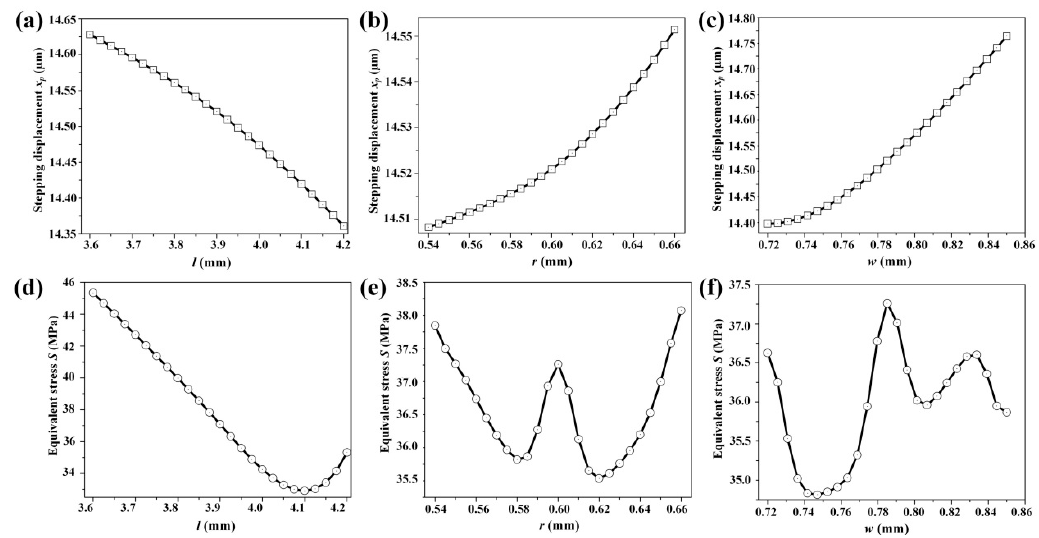
Figure 5. The dependence of the stepping displacement x p and maximum equivalent stress S on each of the design parameters: the change trend of stepping displacement with ( a ) l ; ( b ) r ; ( c ) w ; and the change trend of maximum stress S with ( d ) l ; ( e ) r ; and ( f ) w .